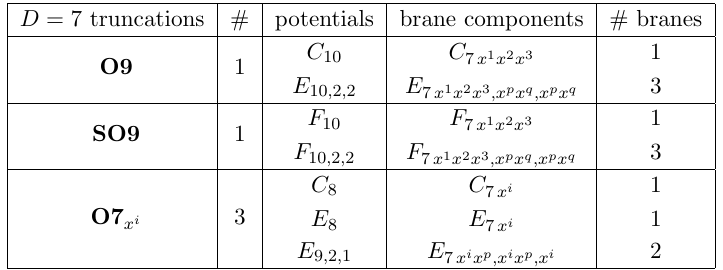
Table 5 . The Z 2 truncations of the maximal theory in D = 7. In the case of the O7 truncation, the i = 1 ; 2 ; 3 index labels the truncation while the p and q indices are di(cid:11)erent from i . In the case of the SO9 truncation, the scalar (cid:8) is proportional to the string dilaton, and SL(4 ; R ) is the perturbative T-duality symmetry. More precisely, one